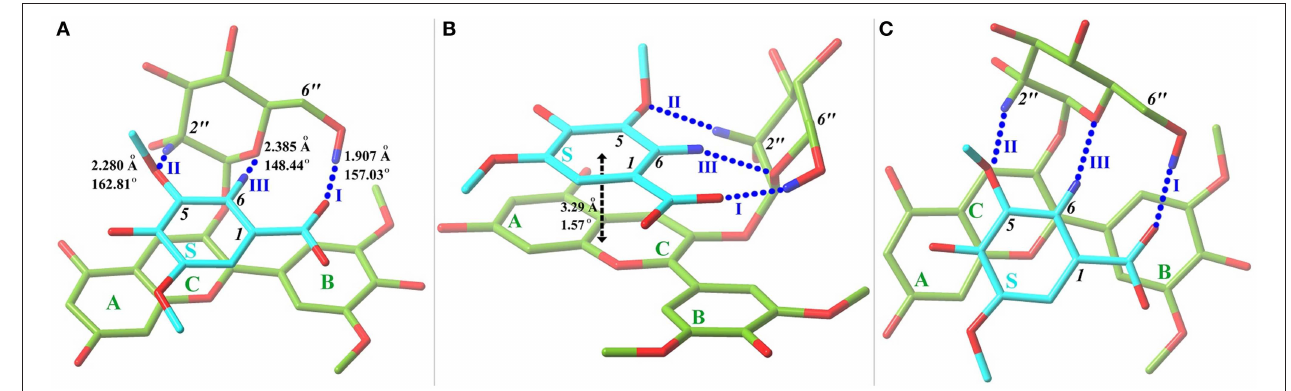
FIGURE 2 | Front (A) , side (B) , and top (C) views of the most stable conformer 1 with a tube molecular representation. Carbon atoms are colored in green for oenin and in cyan for syringic acid. Oxygen and hydrogen (involved in hydrogen bonds) atoms are depicted in red and blue, respectively. HBs, presented in blue dashed lines and numbered, are exhibited with key parameters. The stacking distance and dihedral between oenin rings and syringic acid ring are also included. A fogging depth-cueing is used to improve perception.